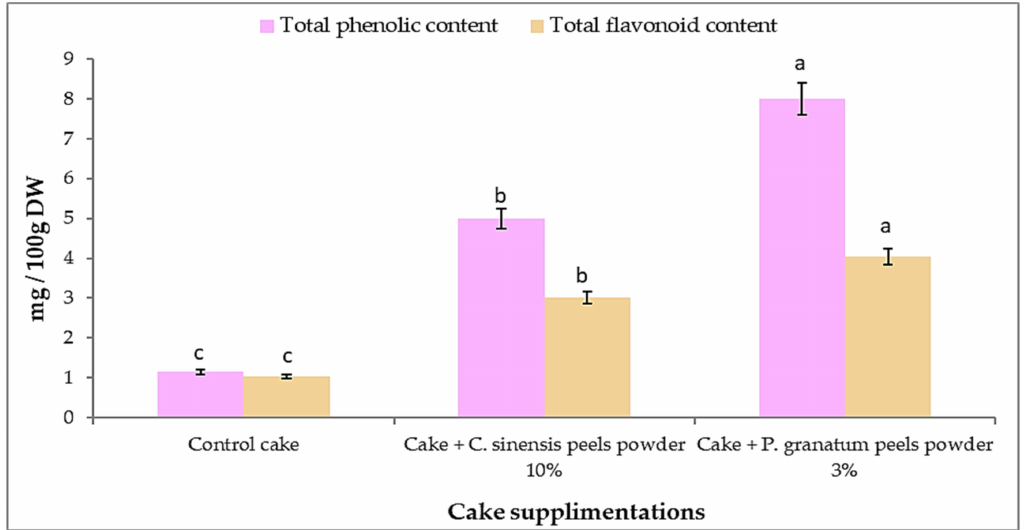
Figure 10. Total phenolic content (mg GAE/100 g DW) and total flavonoid content (mg QE/g DW) of cake supplemented with C. sinensis 10% and P. granatum 3% peel powder. Each value is a mean ( ± SD) of three replicates. The different letters on the same bar show a significant difference according to Duncan’s test at p ≤